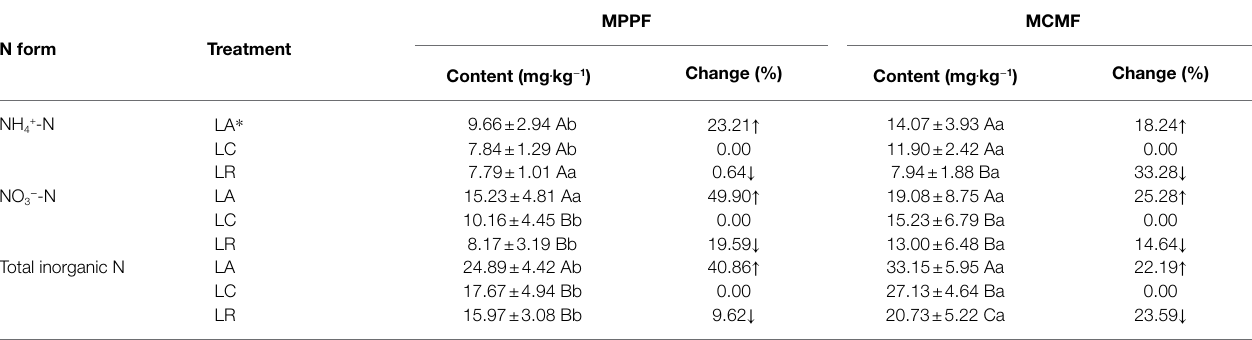
TABLE 2 | Changes in the content of soil nitrogen forms under different litterfall manipulation treatments in two sub-tropical forest types.